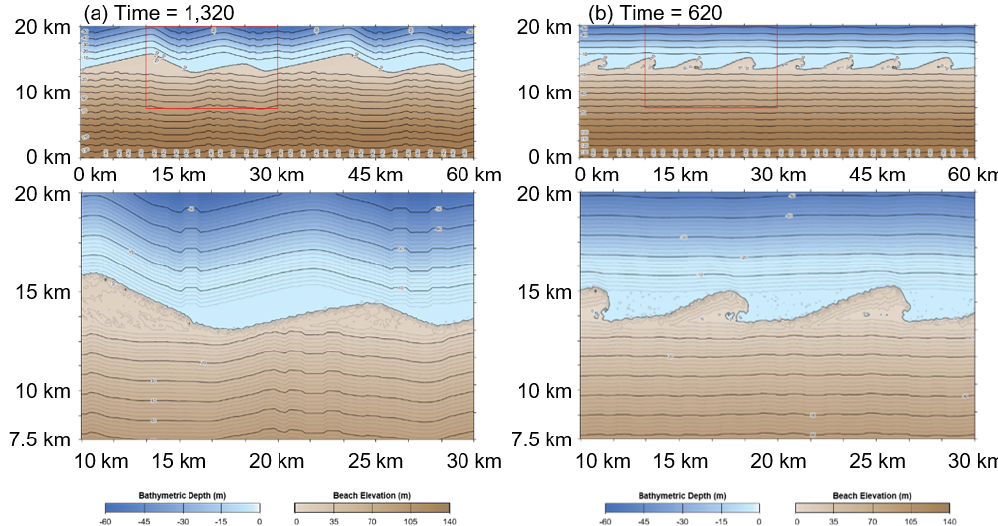
Figure 14. Morphology plots showing outputs of (a) A = 0.6 and U = 0.6 at time = 1320 years and (b) A = 0.7 and U = 0.65 at time = 620